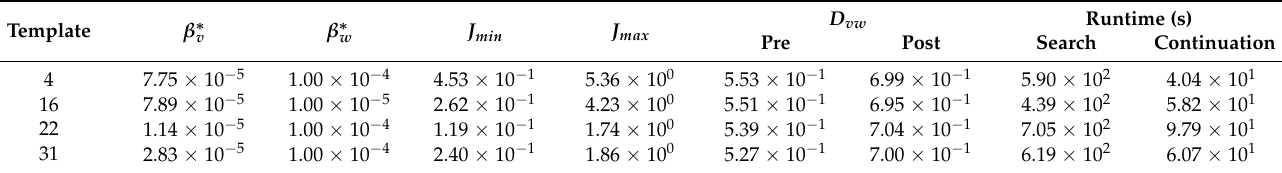
Table 3. Experiment 1: Performance of the parameter search scheme implemented in CLAIRE . We report results for the registration of four template images to the reference image Template27 . We consider the squared L 2 -distance measure as image similarity metric. We restrict the Jacobian determinant J ∈ [ 0.1,10 ] for these registrations. We report the following quantities of interest: (i) optimal regularization parameters β ∗ v and β ∗ w , (ii) minimum J min and maximum J max Jacobian determinant achieved, (iii) solver wall clock time in seconds, and (iv) label volume weighted Dice average D vw pre and post registration.